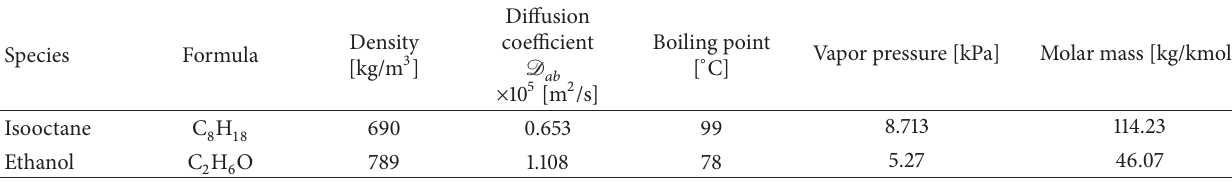
Table 2: Properties of liquid substances used for single droplet and binary droplet experiments.